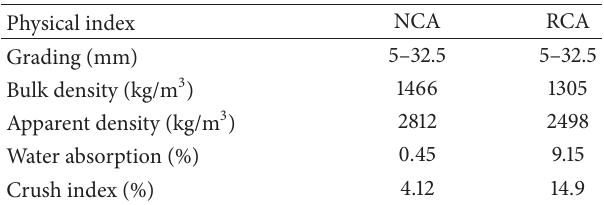
Table 1: Physical properties of NCA and